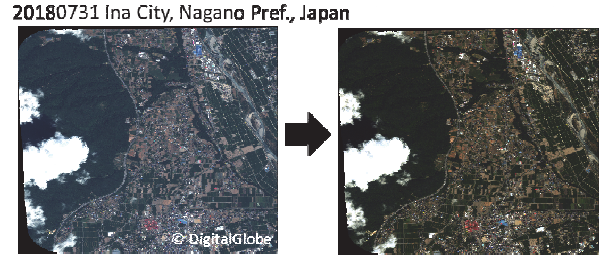
Figure 7. Example of atmospheric correction using WorldView- 2 in Ina City, Nagano Pref.,